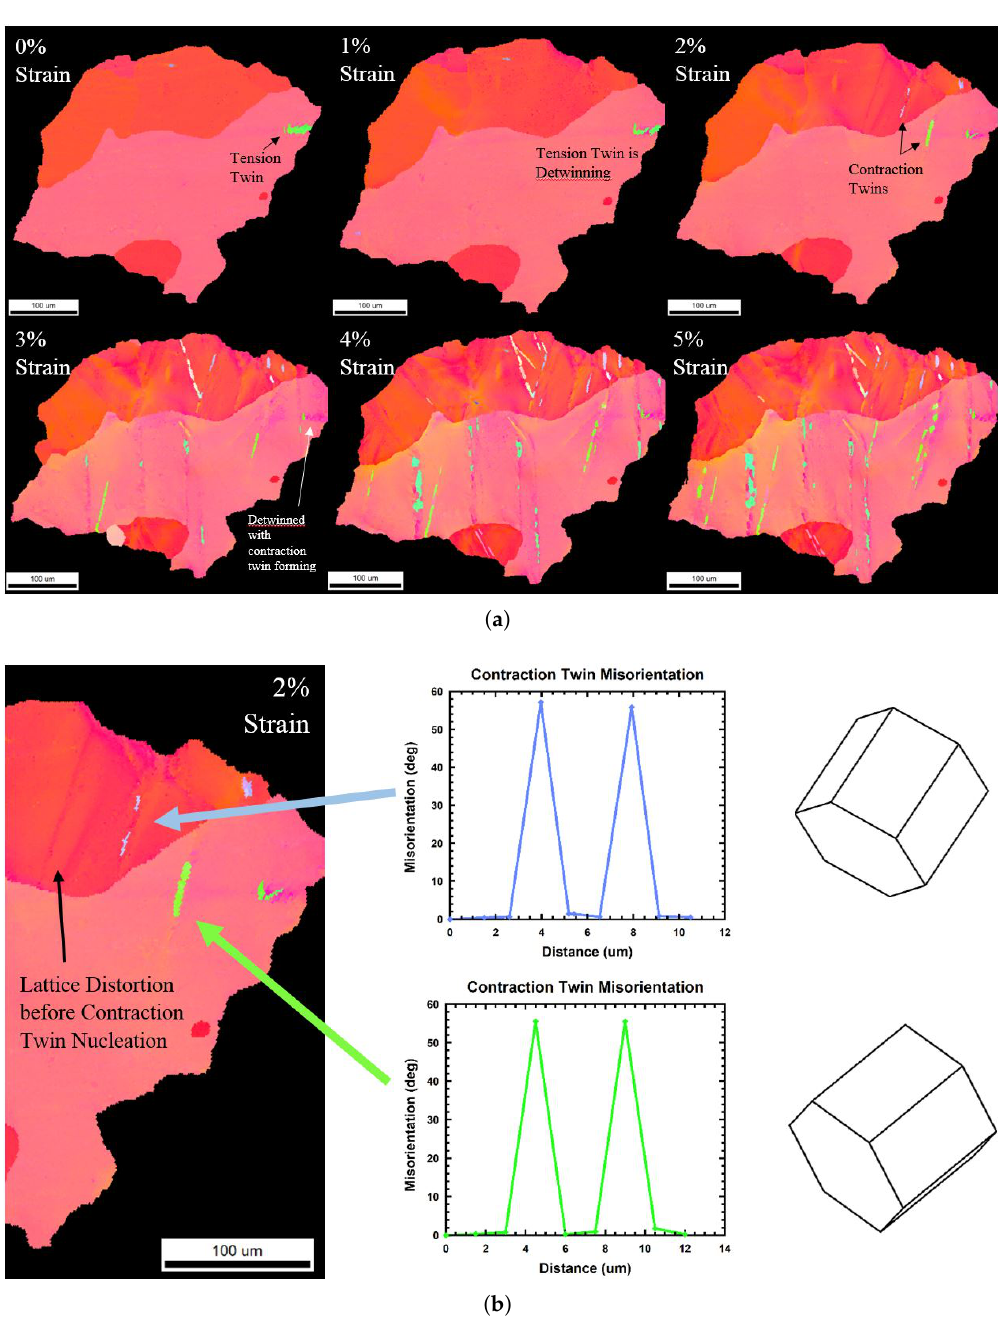
Figure 17. ( a ) Inverse pole maps revealing lattice reorientation due to profuse nucleation of { 1011 } contraction twinning and slip as deformation proceeds from 0% to 5%. Although pyramidal slip (cid:104) c + a (cid:105) has a relatively higher SF, there is profuse nucleation of contraction twins. ( b ) The misorientation data of the twins indicates the presence of contraction twins as early as 2% strain with unit crystal orientation of both twins. The misorientation peak in the plot represents a twin boundary with parent